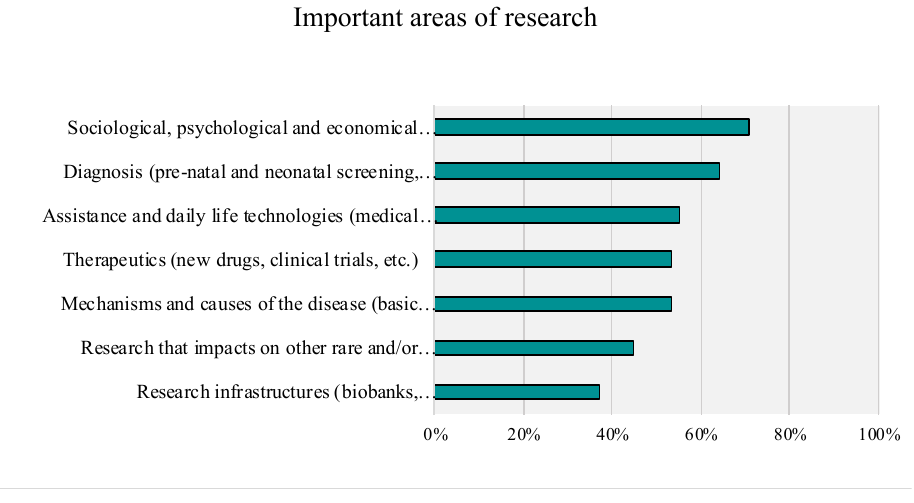
Figure 9. Important Areas of Research. Top ‐ Box Answers are Presented (Rankings of 9 and 10).